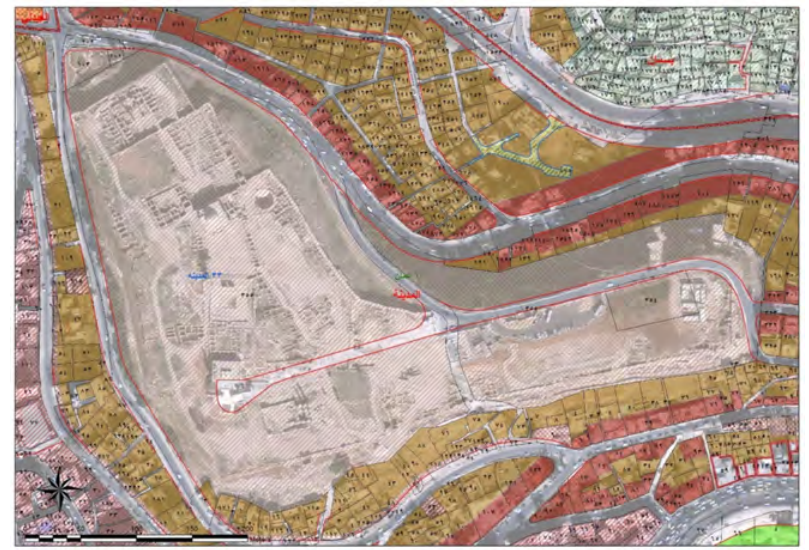
Figure 23. Prohibited area site land use over aerial view map. Source: GAM- GIS for the author (2016).